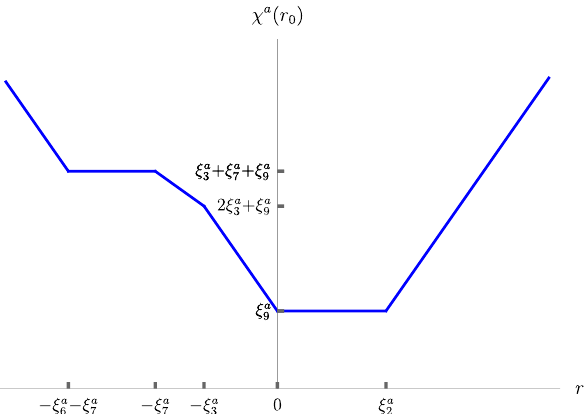
Figure 23: IIA profiles for the horizontal reduction of resolution (a), giving rise an an SU ( 3 ) theory with two